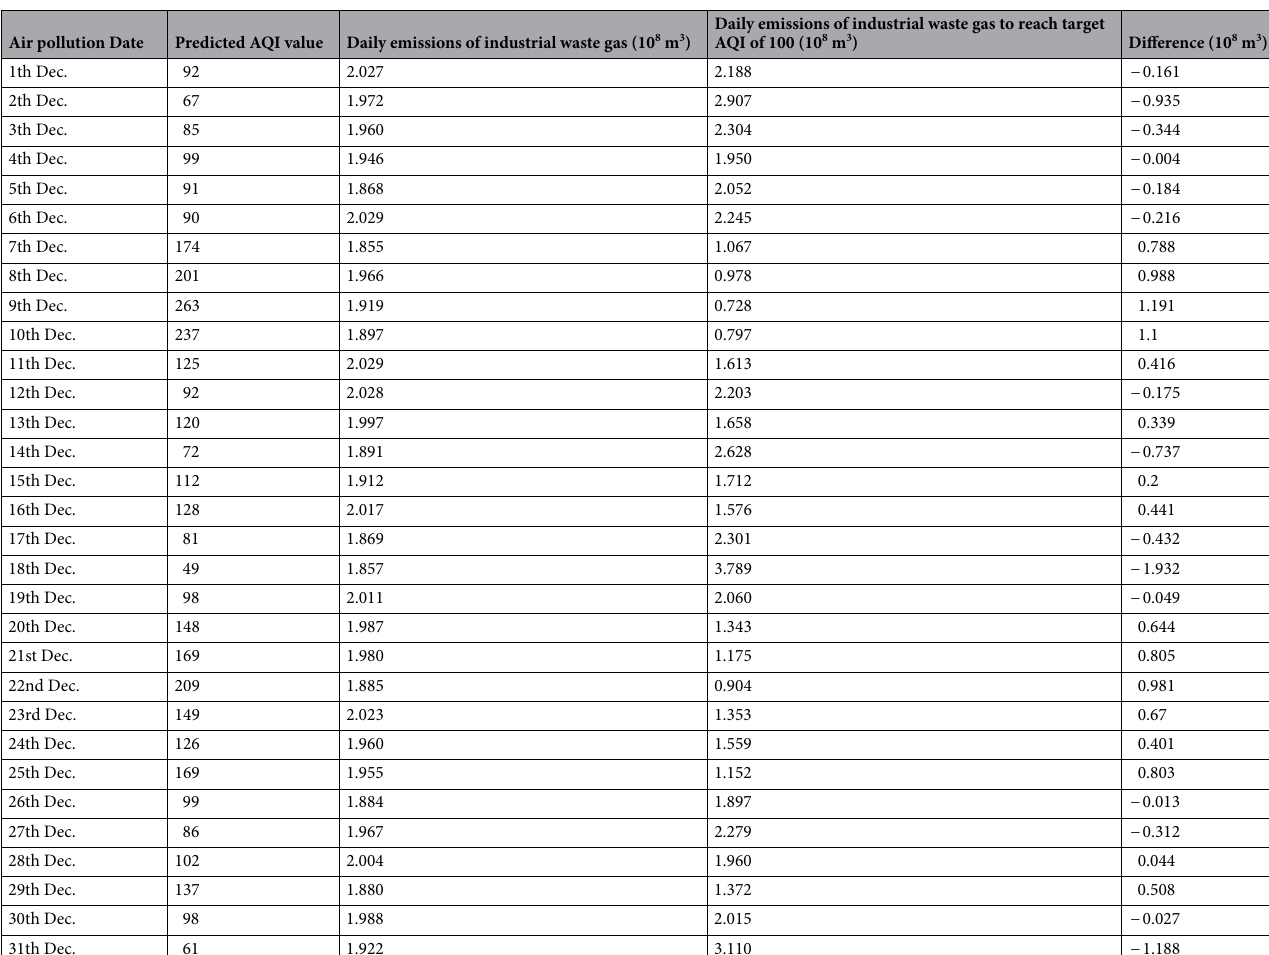
Table 7. Target industrial emissions at AQI of